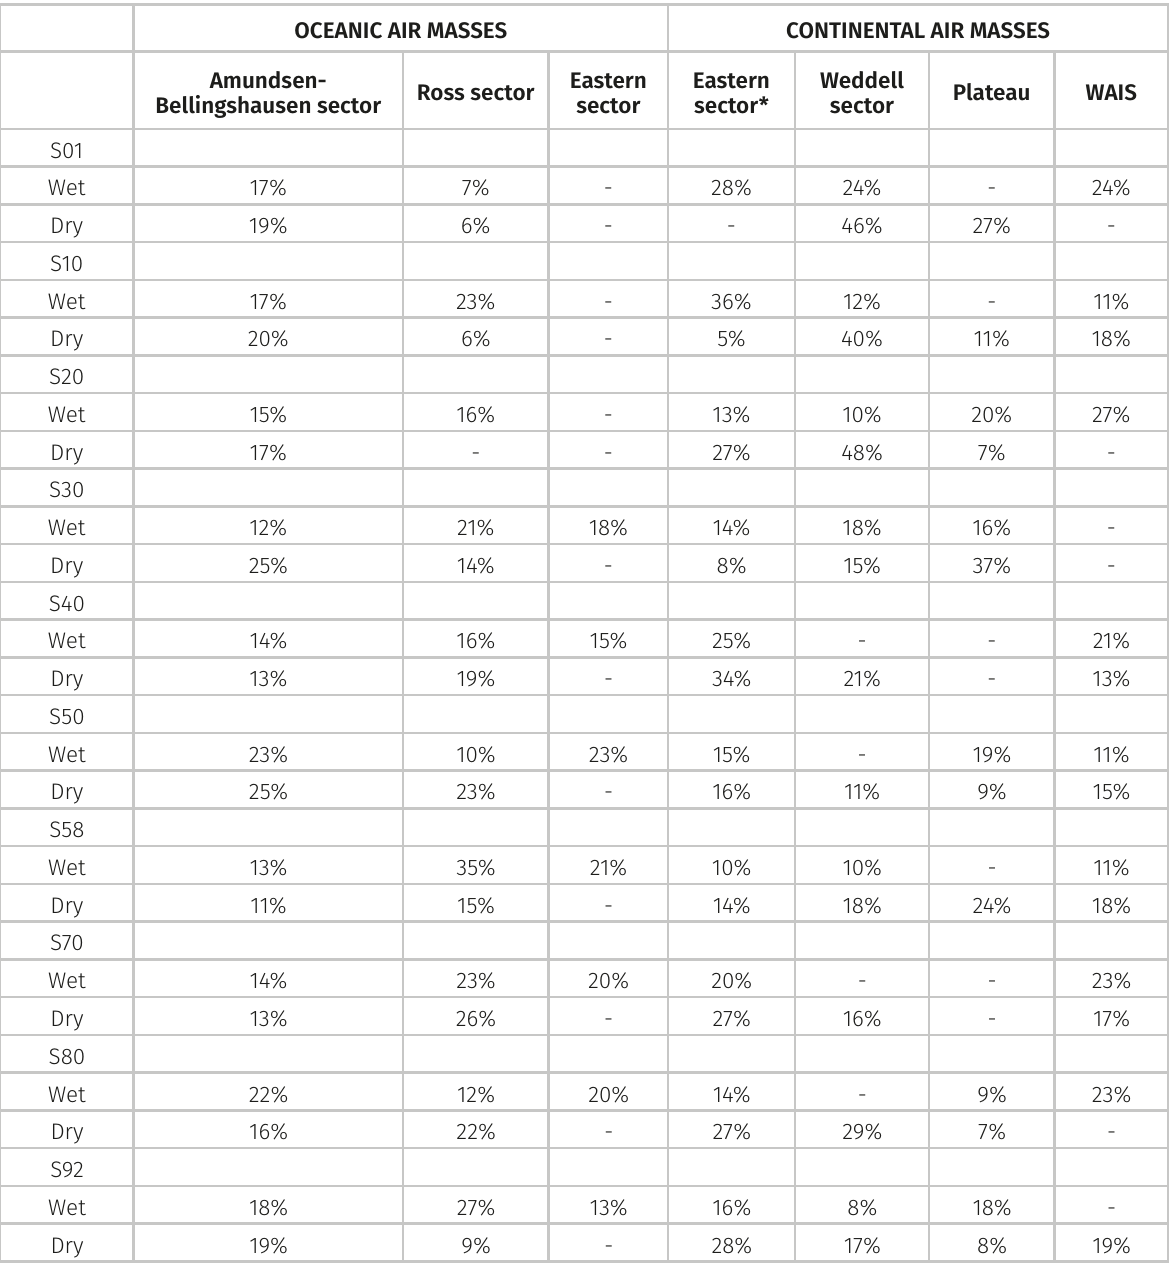
Table II. Frequencies (in percentage) and origin of the oceanic and continental backward air masses trajectories clusters for wet (March–August) and dry (January–February and September–December)